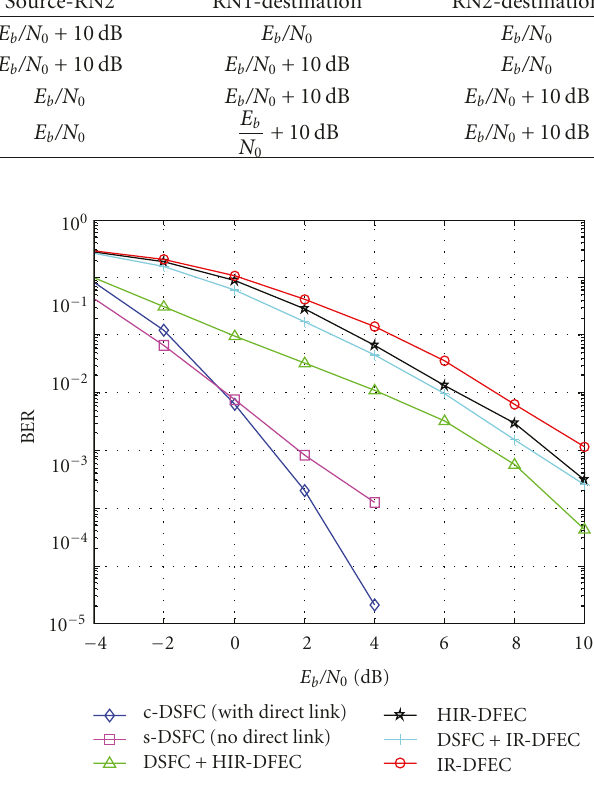
Figure 6: BER versus E b /N 0-directlink ; DSFC, DFEC, and DSFC+DFEC algorithms—scenario